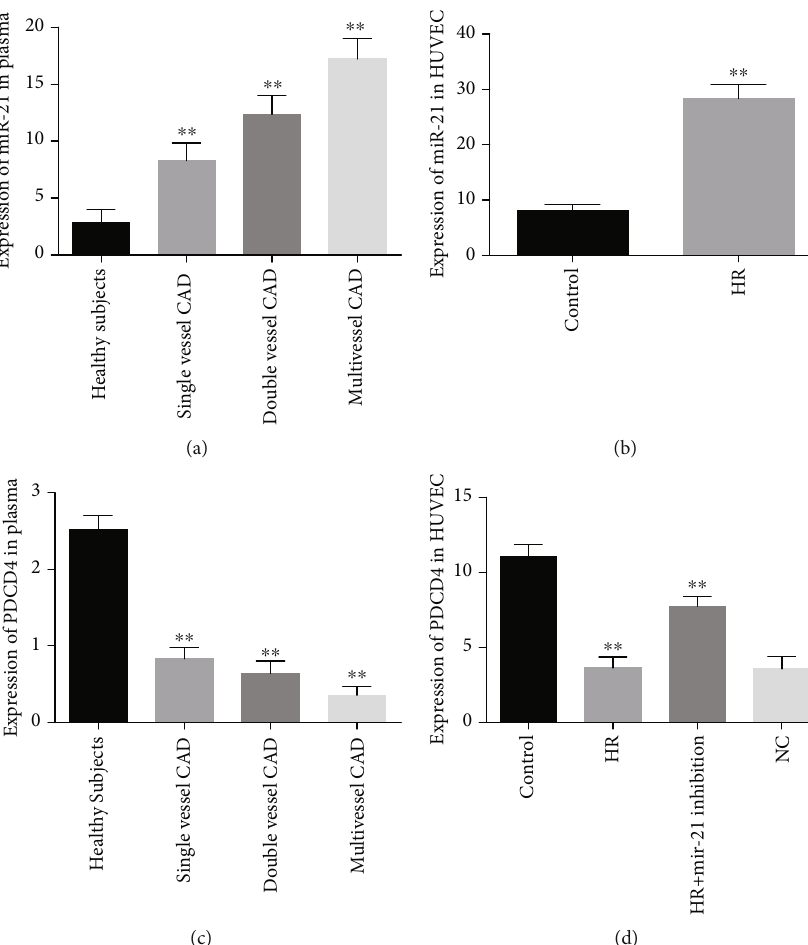
Figure 1: The expression patterns of mir-21 and PDCD4. (a) Circulating mir-21 concentrations in healthy participants versus single-, double-, and multivessel lesion CAD subjects. (b) Expression levels of mir-21 among hypoxic reoxygenation (HR) and normal control HUVECs. (c) The PDCD4 expression patterns between healthy volunteers and disease groups. (d) Comparison of PDCD4 expressions in HR-exposed and normoxic-cultured HUVECs. ∗∗ P < 0 : 001